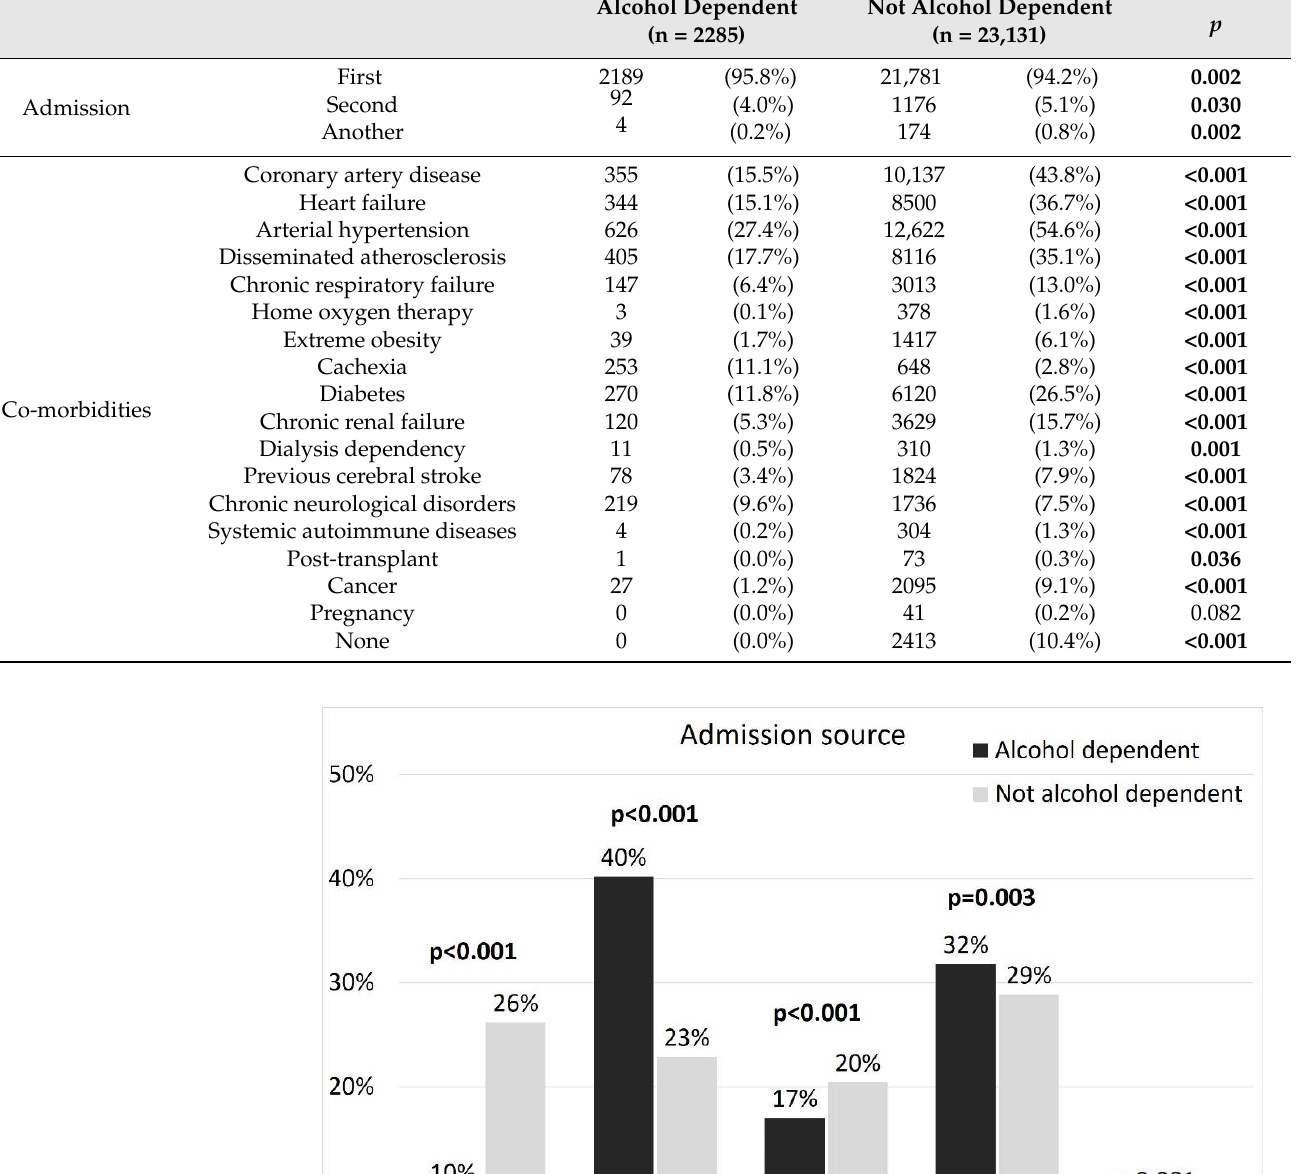
Table 1. Medical status at ICU admission.